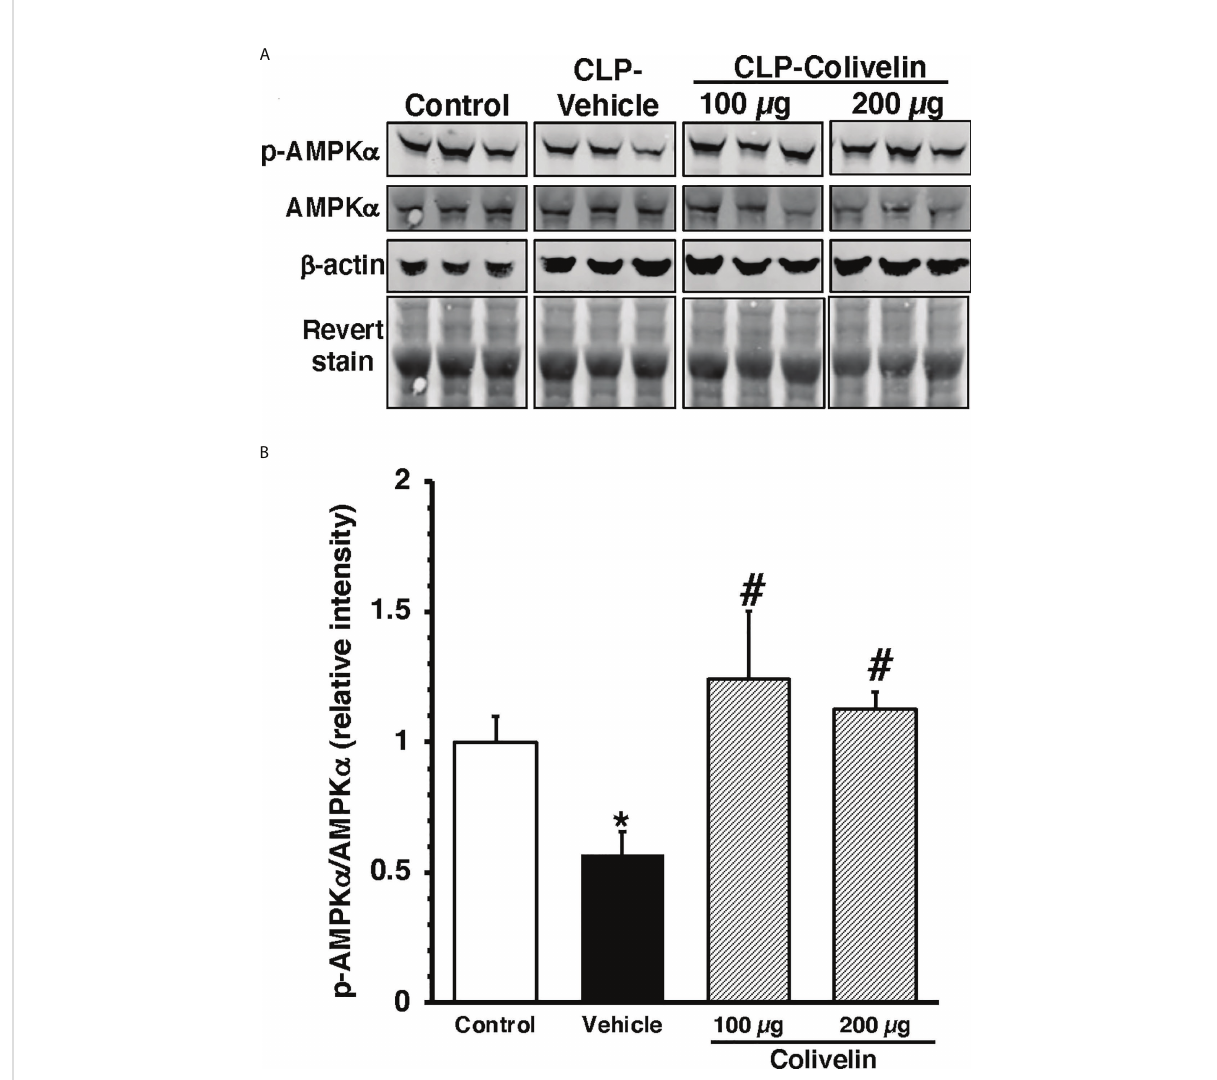
FIGURE 9 Representative Western blots of total AMPK a and pAMPK a in cytosol extracts of thoracic aorta; b -actin and Revert stain were used to verify loading of proteins (A) . Image analyses of ratio of relative intensity of p-AMPK a /AMPK a (B) as determined by densitometry. Vehicle (200 µl distilled water) or colivelin (100 µg/kg) was administered intraperitoneally at 1 h after CLP. Each data represents the mean ± SEM of 3-4 mice for group (n=3 control group, n=4 vehicle group, n=4 colivelin 100 µg group). *Represents P < 0.05 versus control mice; #represents P < 0.05 versus vehicle-treated